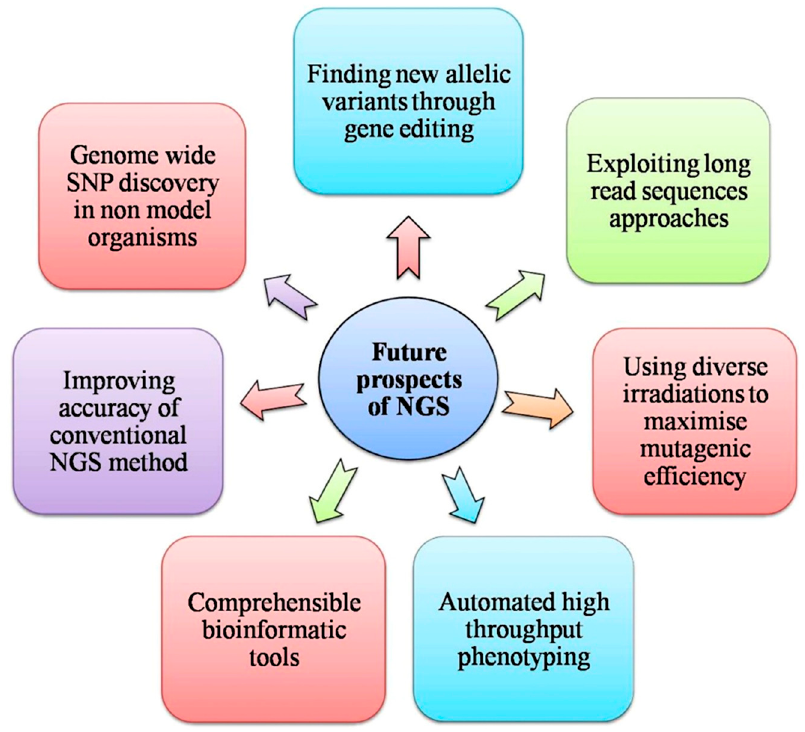
Figure 9. Future prospects of next generation sequencing for crop improvement.